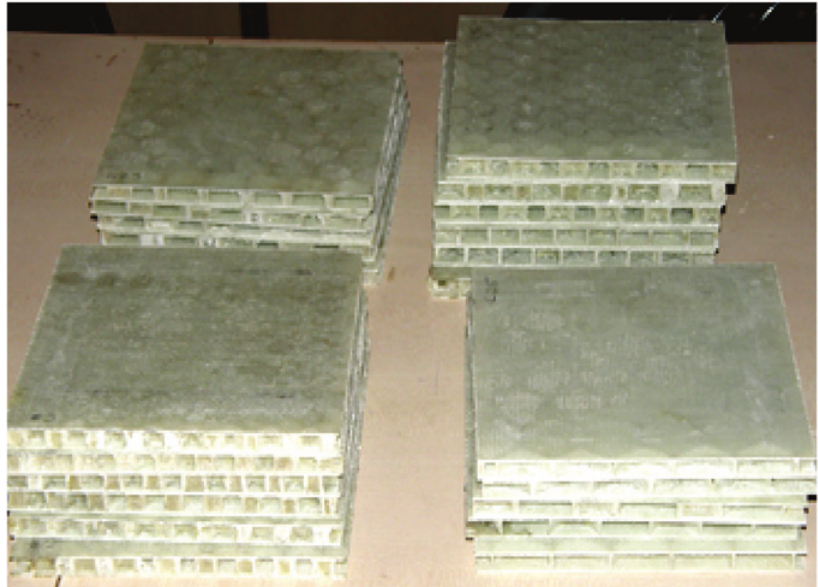
Figure 2 Honeycomb sandwich panels.